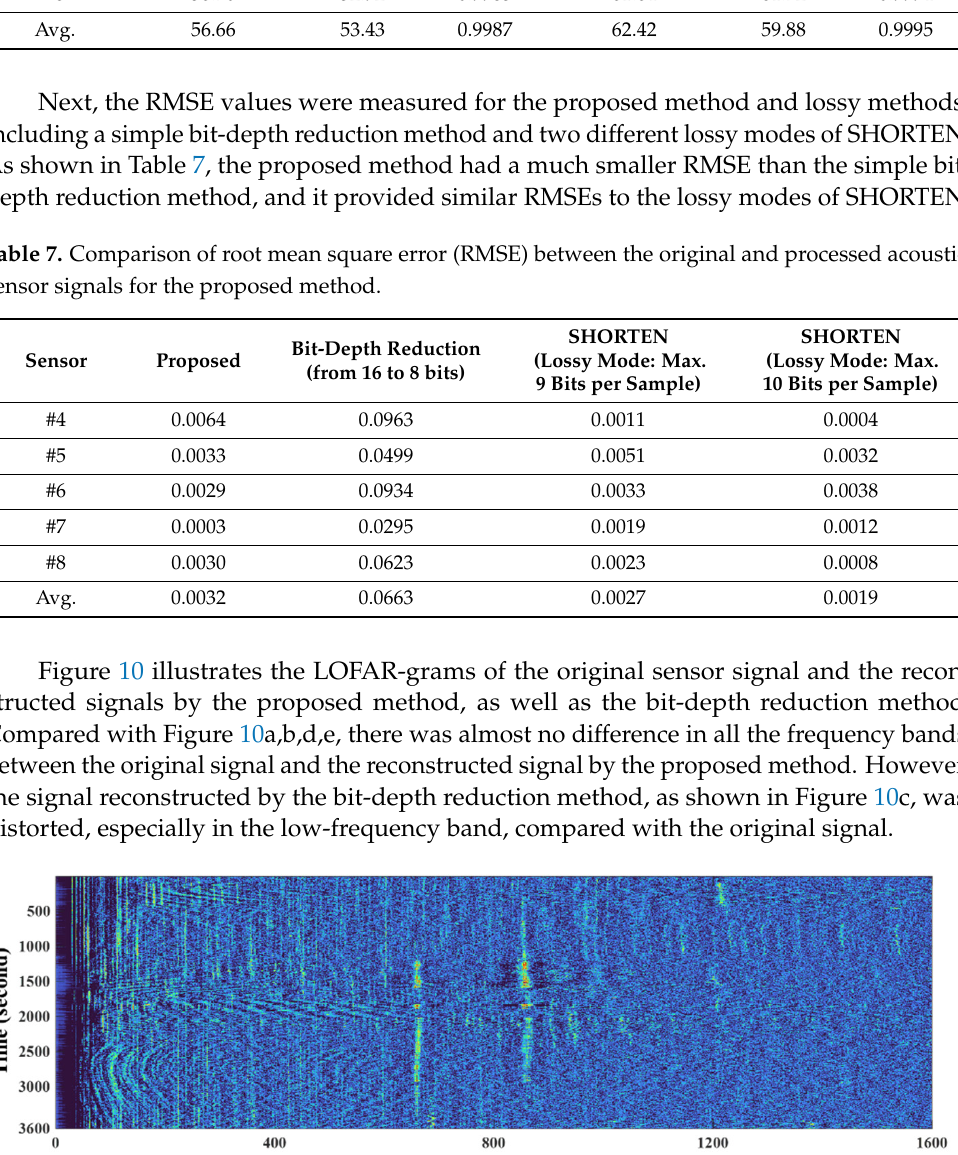
Table 7. Comparison of root mean square error (RMSE) between the original and processed acoustic sensor signals for the proposed method.